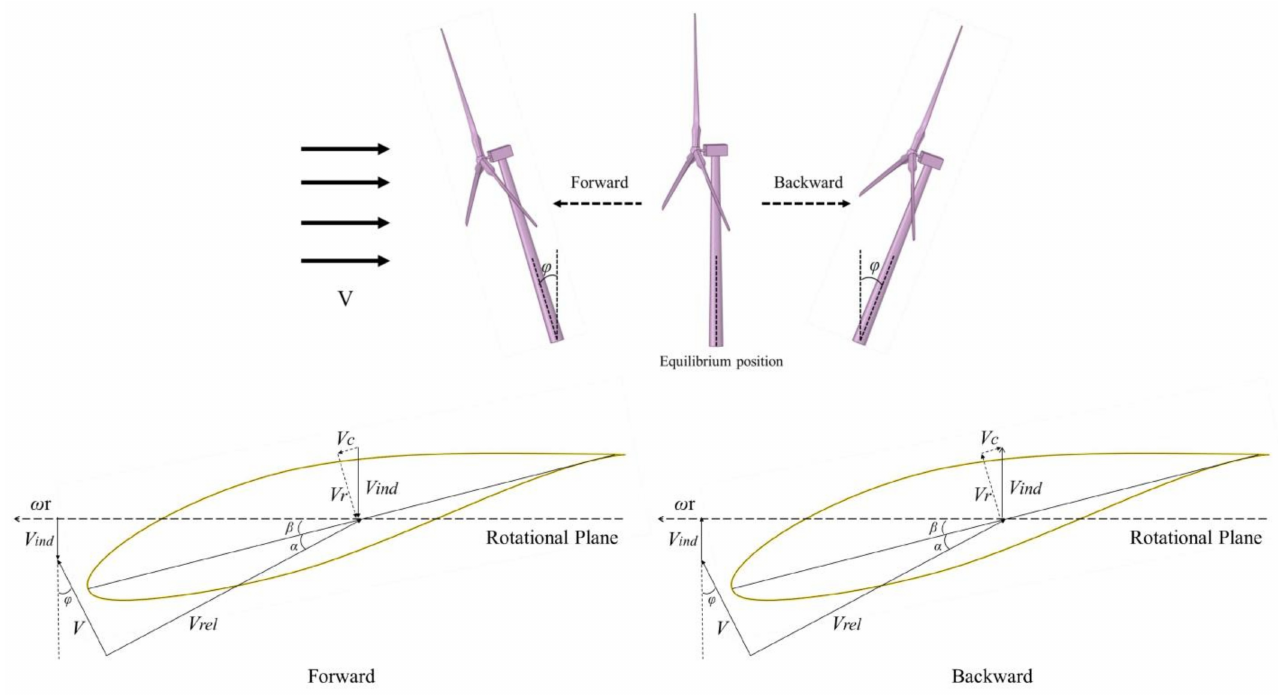
Figure 14. Schematic diagram of airfoil-induced velocity under pitch motion.